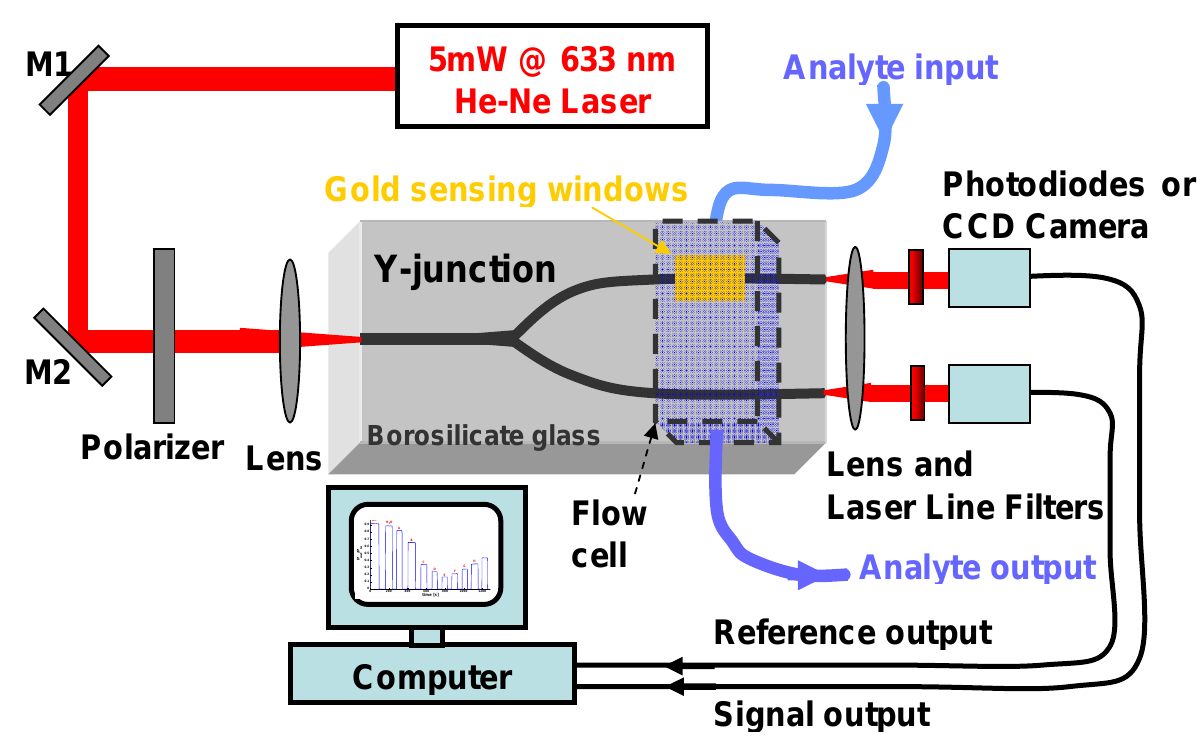
Figure 10. Measurement setup for the Y-junction device.